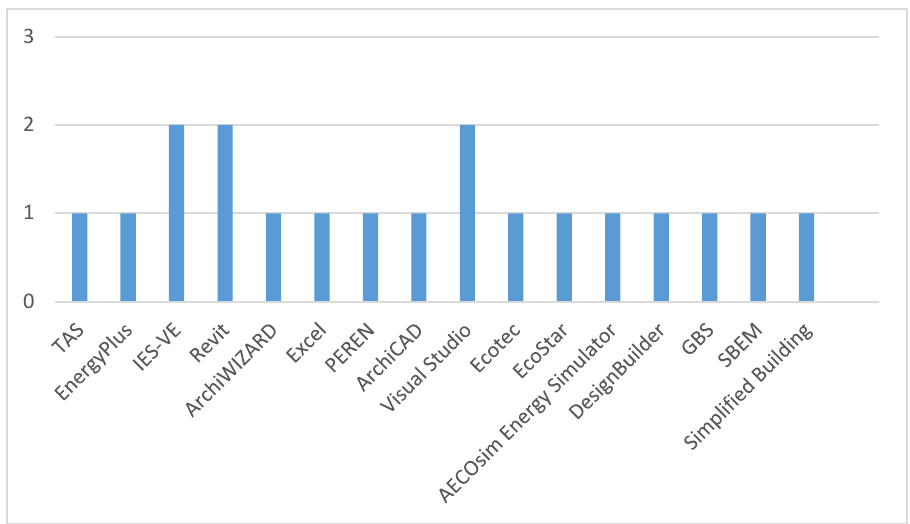
Figure 4. Applied software to assess BREEAM criteria.